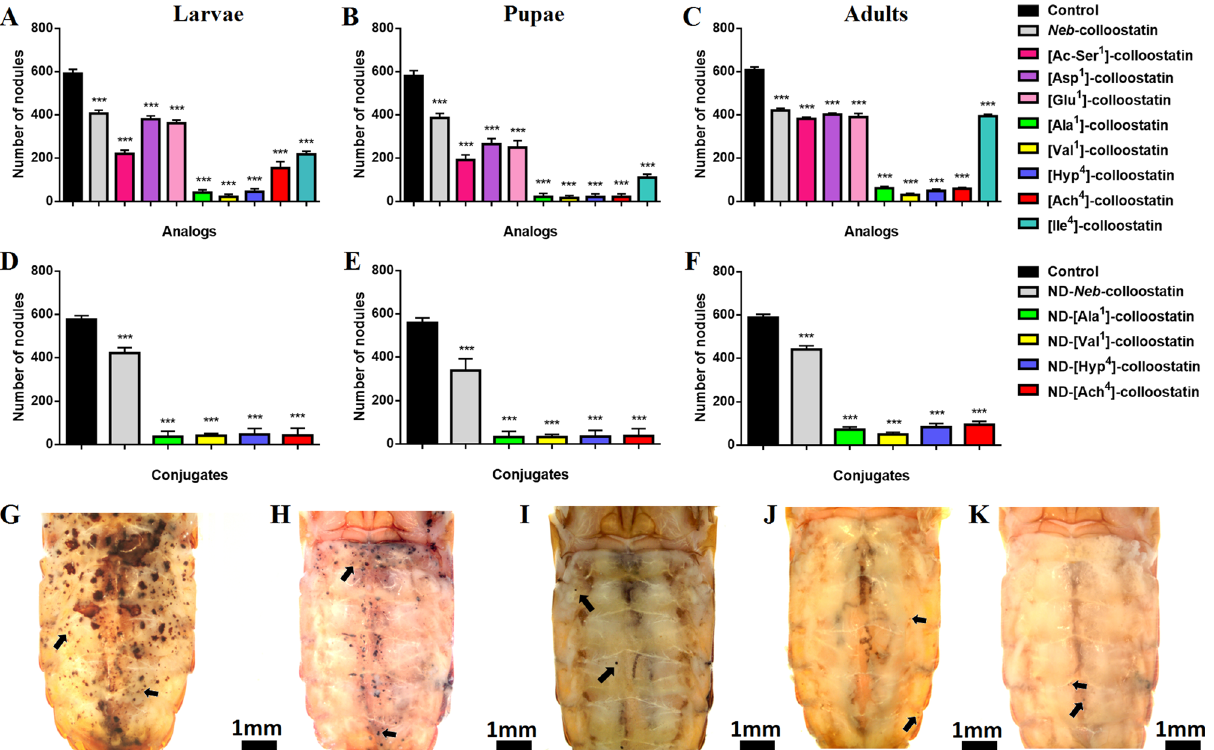
Figure 3. Nodule formation in T. molitor larvae ( A , D ), pupae ( B , E ) and adults ( C , F ) following injections of Neb -colloostatin or one of its analog at doses of 2 ng of peptide per insect ( A – C ) and following topical applications of ND- Neb -colloostatin or conjugates of NDs and the most potent analogs at doses of approximately 4.15 µg of NDs and 0.85 µg of peptide per insect ( D–F ). Representative photos are provided of the hemocoels of T. molitor adults taken 3 days after the injection of physiological saline ( G ), [Ala 1 ]-colloostatin ( H ), [Val 1 ]-colloostatin ( I ), [Hyp 4 ]-colloostatin ( J ) or [Ach 4 ]-colloostatin ( K ). Nodule formation was induced by injection of 5 μ L of Staphylococcus aureus in suspension. The black arrows show some examples of nodules. The values shown are means ± S.D. The results significantly different from those of the control group are indicated: p < 0.005